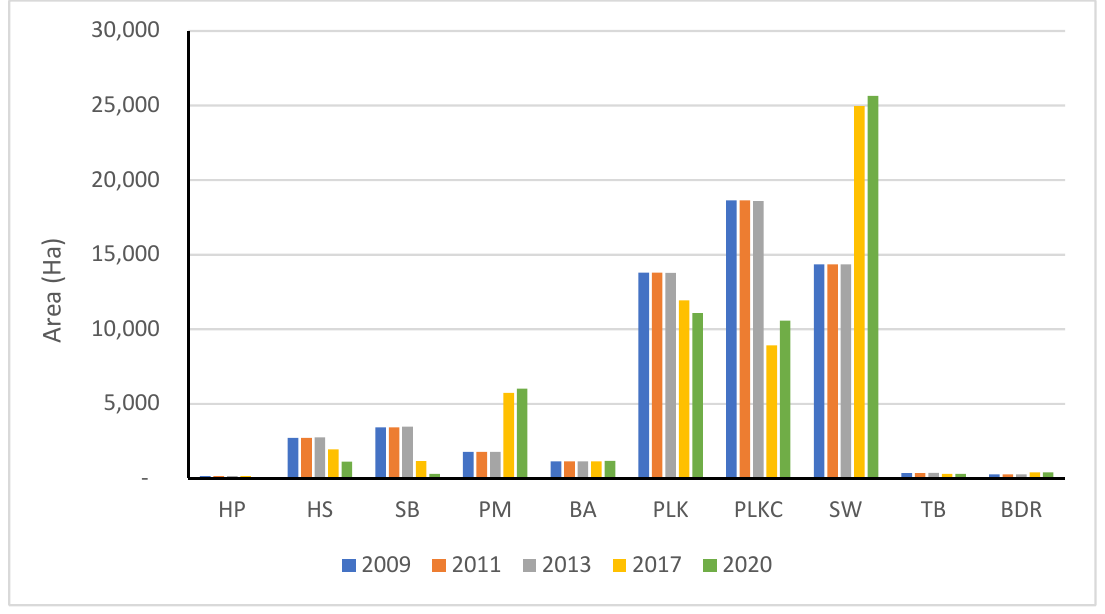
Figure 2. The dynamics of land use change in the Dodokan Watershed from 2009–2020. Remarks: